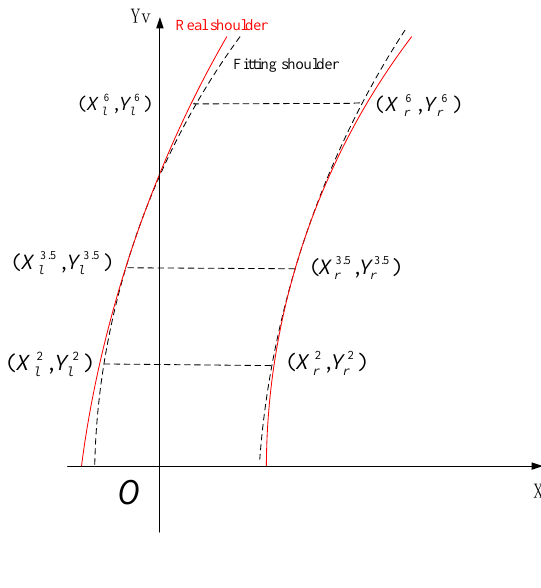
Figure 3. Road curb fitting.